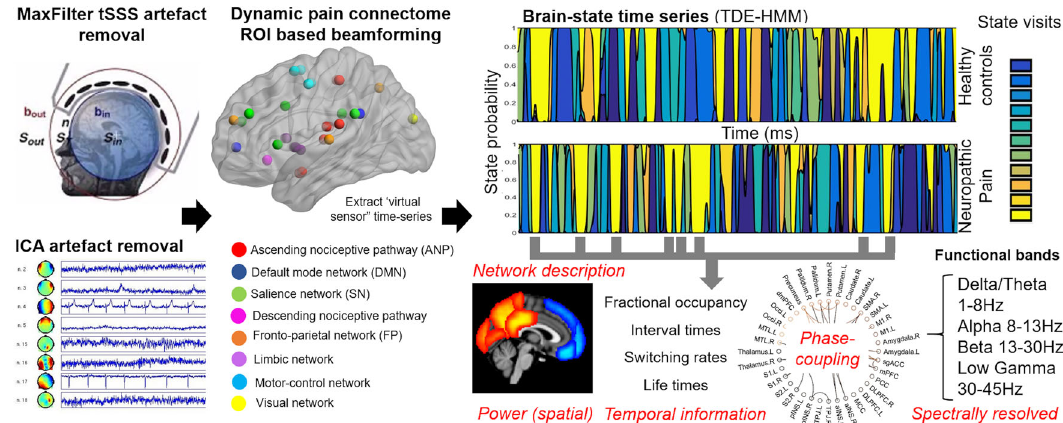
Fig. 1 Illustration of time-delay embedded Hidden Markov Model (TDE-HMM) approach applied on MEG data. MEG data preprocessing (Independent component analysis (ICA) for artifact removal, source reconstruction, parcellation, leakage correction, and sign disambiguation — see Methods). We used a linearly constrained minimum variance beamformer to extract a continuous time series for nodes of the dynamic pain connectome based on anatomical 3D T1 scans of each participant. Spontaneous cortical activity transiently organizes into frequency-speci fi c phase-coupling networks. Principal component analysis was applied for dimensionality reduction, and HMM inference was then used to identify the state time-courses (state probability) and the state parameters in HCs and those with neuropathic pain. Each state was characterized as having its own distinct spatial, temporal, and spectral properties. Individual power maps and phase-coupling patterns (networks) were estimated for active states and illustrated by their temporal features (i.e., fractional occupancy, interval times, switching rates, and lifetimes). States were spatially de fi ned and spectrally resolved according to the main frequency bands (i.e., delta/theta, alpha, beta, and low